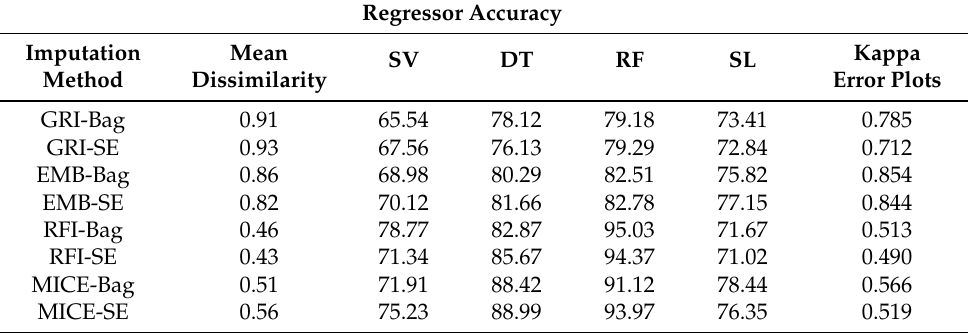
Table 1. Mean dissimilarity, regressor accuracy and Kappa error plots for different imputation methods. SV—support vector; DT—decision tree; RF—random forest; SL—simple linear; Bag—bagging ensemble; SE—stacking ensemble.